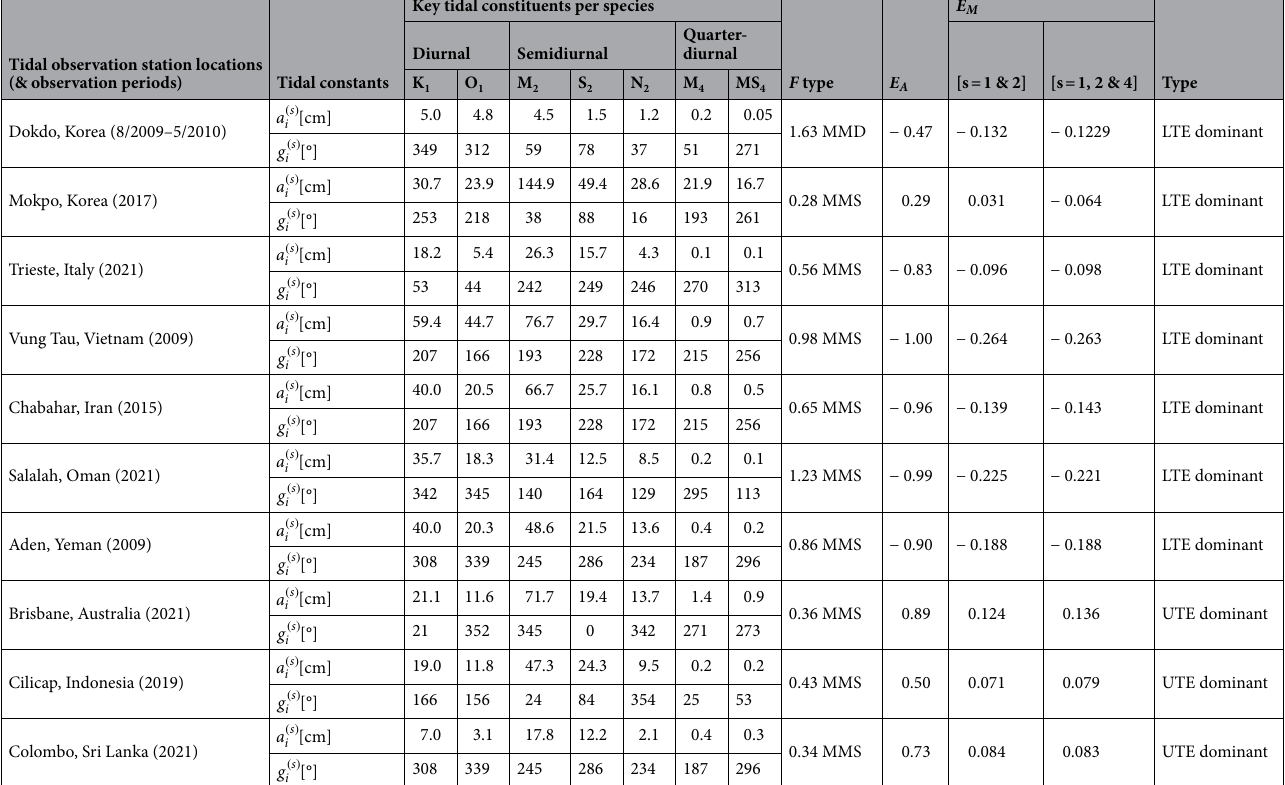
Table 2. Comparison of key tidal species’ harmonic analysis and tidal form ( F ) data and our two different tidal envelope classifications ( E A and E M ) for ten sites from a range of mixed tide regimes distributed across the globe as derived from sea level observation data. The number of tidal constituents examined per tidal species in the E M experiments in this study was 21 for the diurnal species, 18 for the semidiurnal species and 7 for the quarterdiurnal species. Dokdo has a mixed, mainly diurnal tide regime while Mokpo, Trieste, Vung Tau, Chabahar, Salalah, Aden, Brisbane, Cilicap and Colombo have mixed, mainly semidiurnal regimes, with Mokpo also being characterized by relatively strong shallow water tides (see Fig. 4c for a location map). Tidal harmonic analyses employed UTide 25 , and data records of between 288 and 365 days per site, with results ( s ) g ( s ) shown for the 7 most important tidal constituents. a i and i indicate the amplitudes and phase lags of the tidal constituents, respectively. S indicates tidal species, while the subscript i indicates each tidal constituent. F is the tidal form number, with MMD indicating mixed, mainly diurnal tides and MMS indicating mixed, ) , and E M is the difference between the mean upper tidal − g + g O mainly semidiurnal tides. E A = cos ( g K 1 1 M 2 envelope and absolute mean lower tidal envelope (see Eq. (9)). Phase lags for Dokdo and Mokpo were referenced to Korean Standard Time (KST), while for all other sites these were referenced to Greenwich Mean Time. ‘LTE dominant’ denotes an envelope with a lower curve that closely approximates the minimum potential lower tidal envelope curve. ‘UTE dominant’ denotes an envelope with an upper curve that closely approximates the maximum potential upper tidal envelope